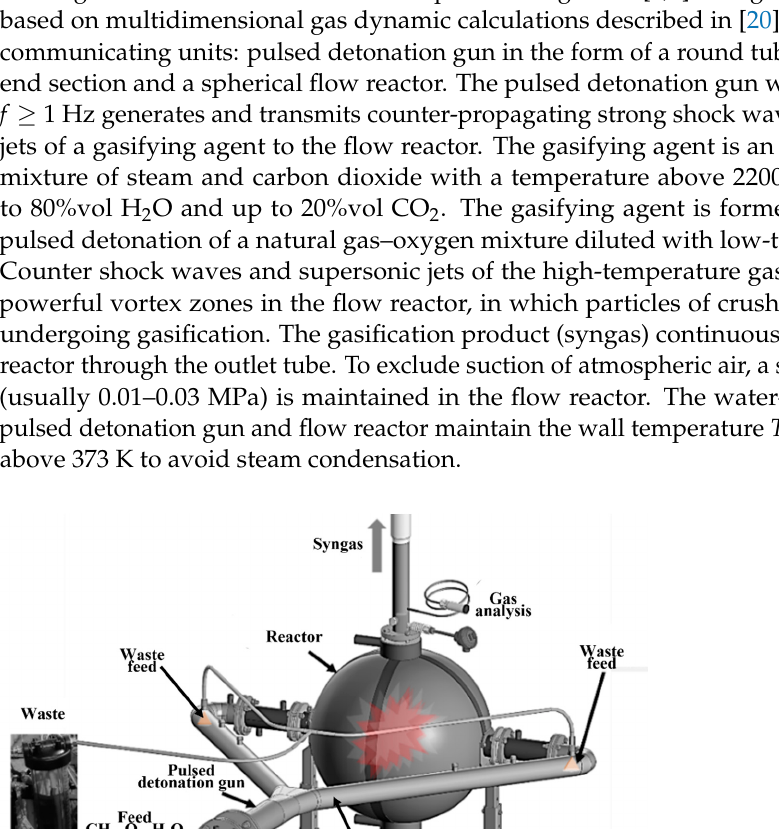
Figure 3. Calculated time histories of mean temperature in the flow reactor at pulsed detonation gun operation with a frequency of (cid:1858) = 5 (1) и 1 Hz (2) without waste feed: (cid:1846) (cid:3050) = 450 K, (cid:1842) = 0.1 MPa.